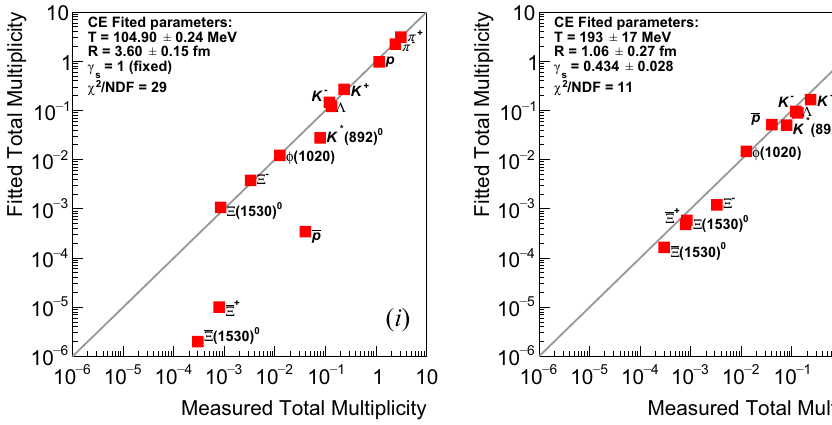
Fig. 11 Mean multiplicities of π + , π − , K + , K − , p , p , K ∗ ( 892 ) 0 , (cid:4) , φ( 1020 ) , (cid:2) − , (cid:2) + , (cid:2)( 1530 ) 0 and (cid:2)( 1530 ) 0 produced in p+p interac- tions at 158 GeV / c [3,4,12,17–20] measured by NA61/SHINEare com-